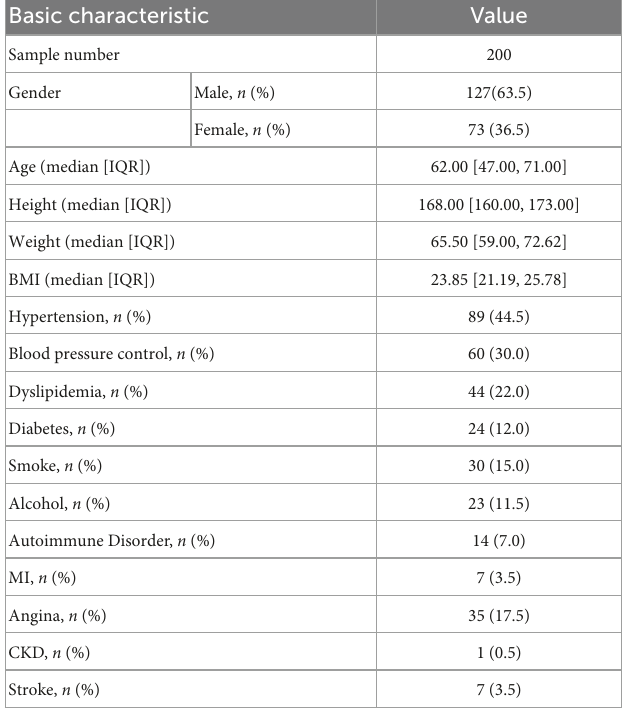
TABLE 1 Basic characteristics of